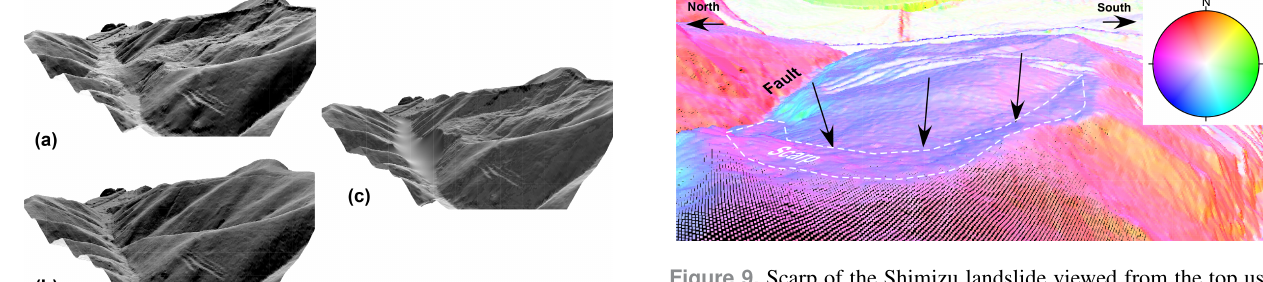
Figure 9. Scarp of the Shimizu landslide viewed from the top us- ing the COLTOP scheme, which provides the colour of the normal vectors to the topography in the lower hemisphere. The scarp (area defined by the white dashed line) illustrates the precursory move- ments. The arrows indicate the top of the moved mass.